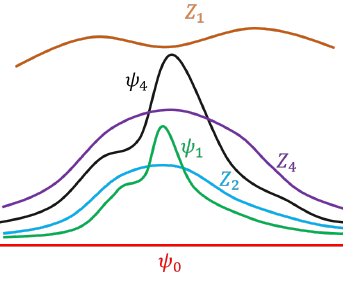
Fig. 8: Subsolutions ψ 0 , ψ 1 , ψ 4 and supersolutions Z 1 , Z 2 , Z 4